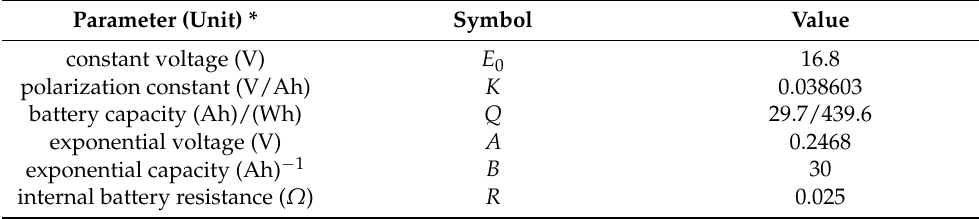
Table 4. Battery model parameters used in the numerical experiment. Parameter (Unit) * Symbol Value constant voltage (V) E 0 16.8 polarization constant (V/Ah) K 0.038603 battery capacity (Ah)/(Wh) Q